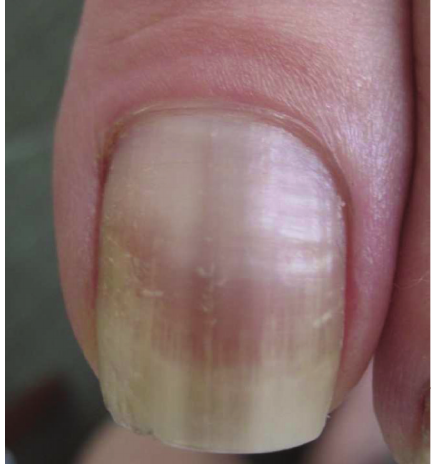
Figure 2: Traumatic melanonychia following a fracture of the great toe.